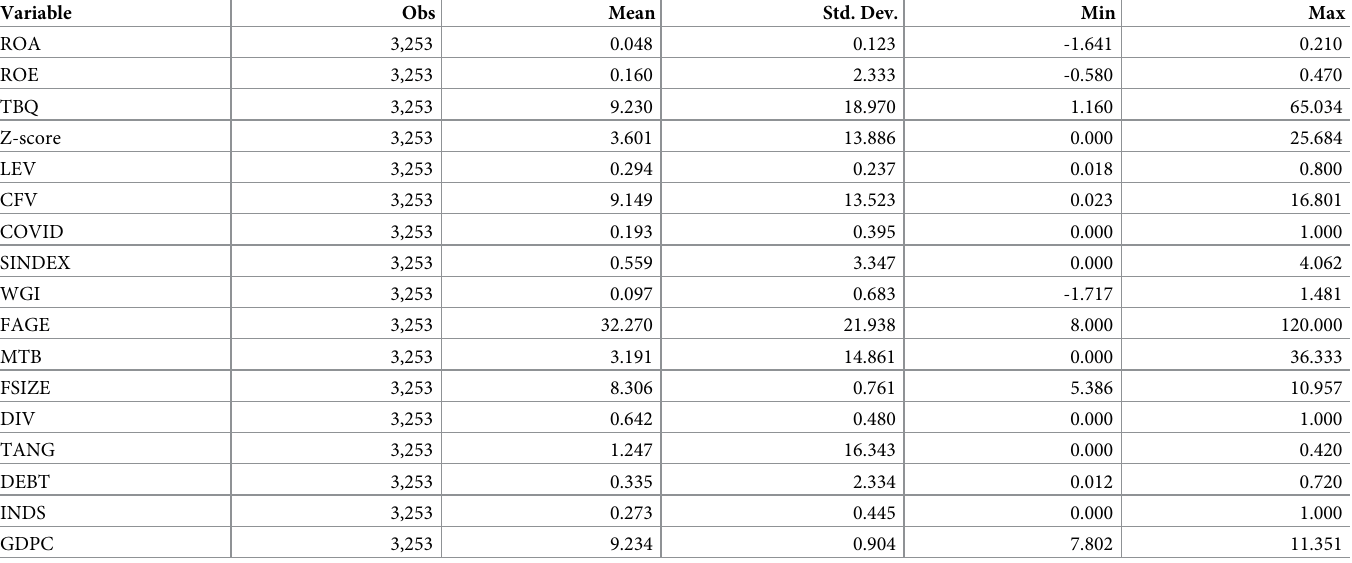
Table 2. Descriptive